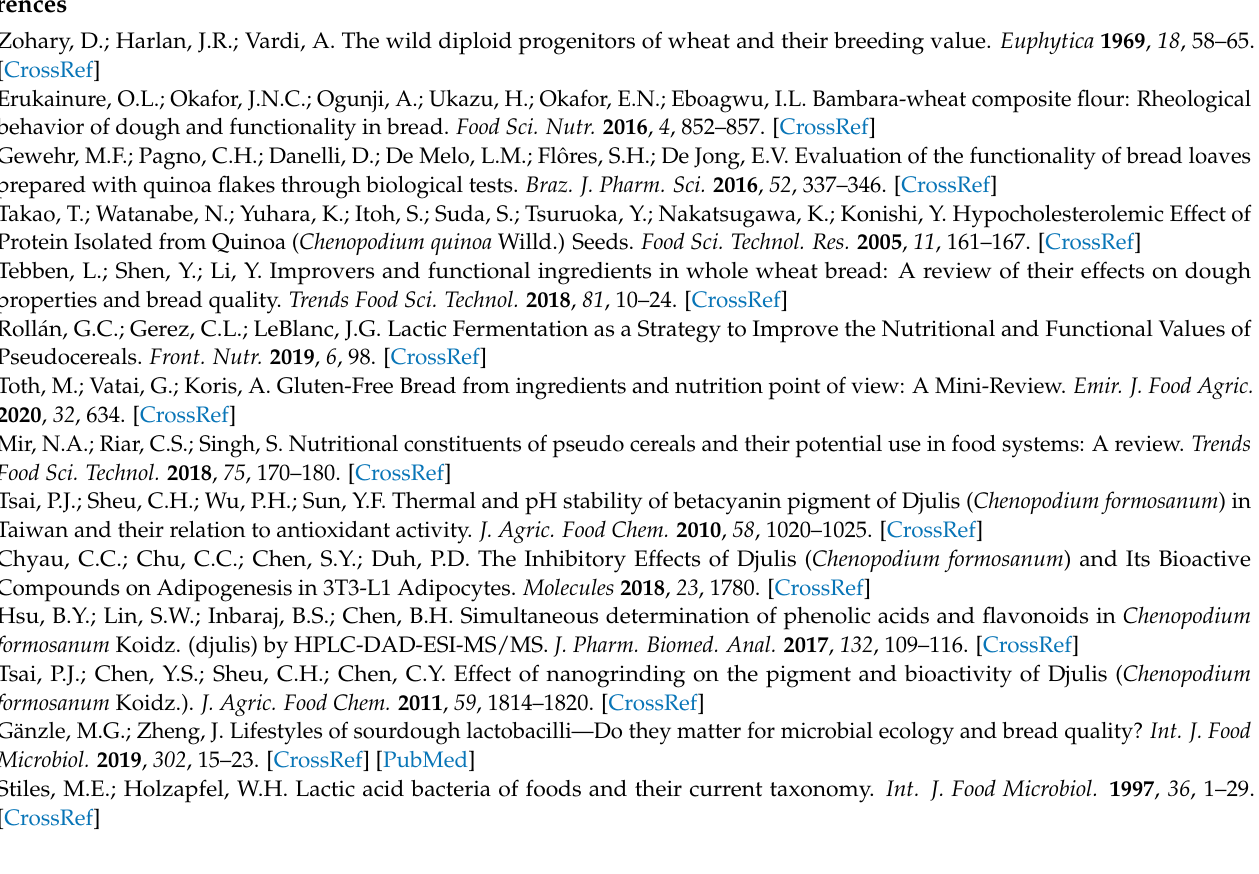
Supplementary Materials: Table S1: Organoleptic evaluation